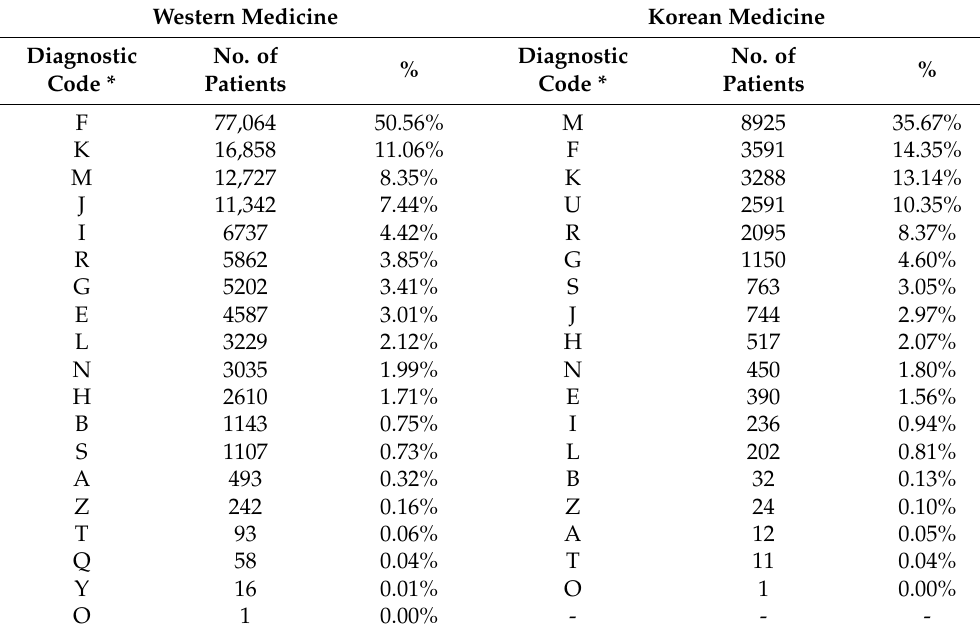
Table 5. Comorbidities of patients with